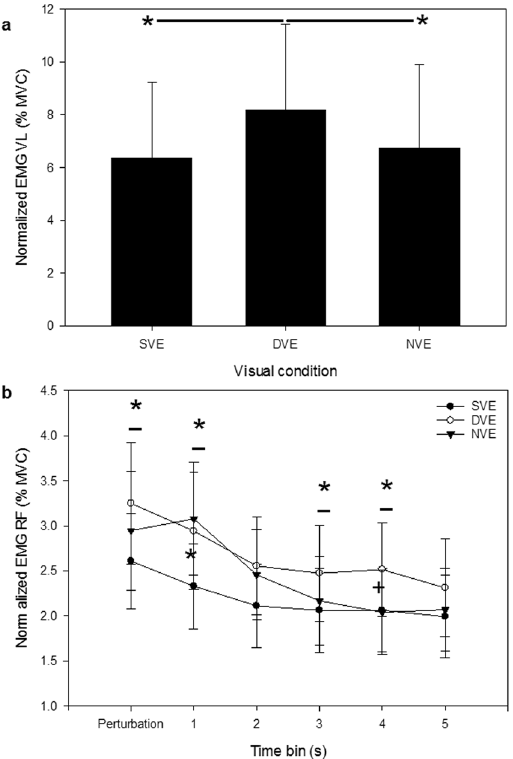
Figure 4. Influences on muscle activity after the perturbation. ( a ) The effect of different visual environments on vastus lateralis muscle activity after the mechanical perturbation. ( b ) The effect of visual environments and time on rectus femoris activity levels after the mechanical perturbation. Muscle activity is presented as the percent of the participants’ maximum voluntary contractions (MVC). Horizontal black lines with asterisks indicate significant post-hoc comparisons between visual conditions. SVE: static visual environment; DVE: dynamic visual environment; NVE: No visual environment. See methods for description of time bins. * P <